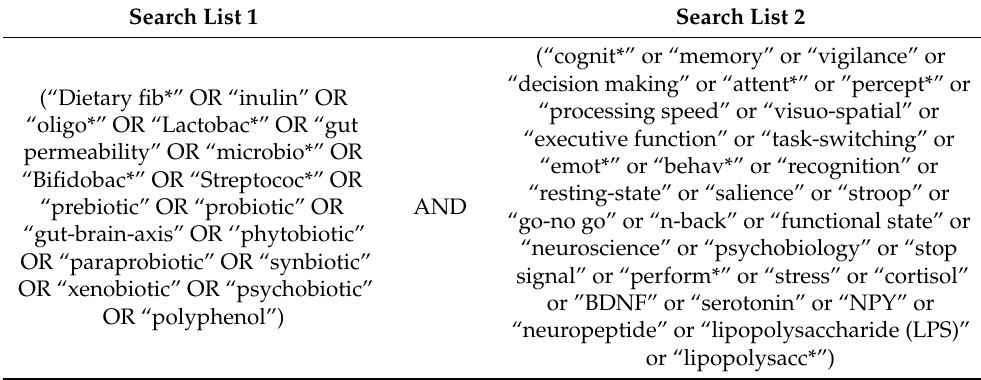
Table 1. Search list items for literature